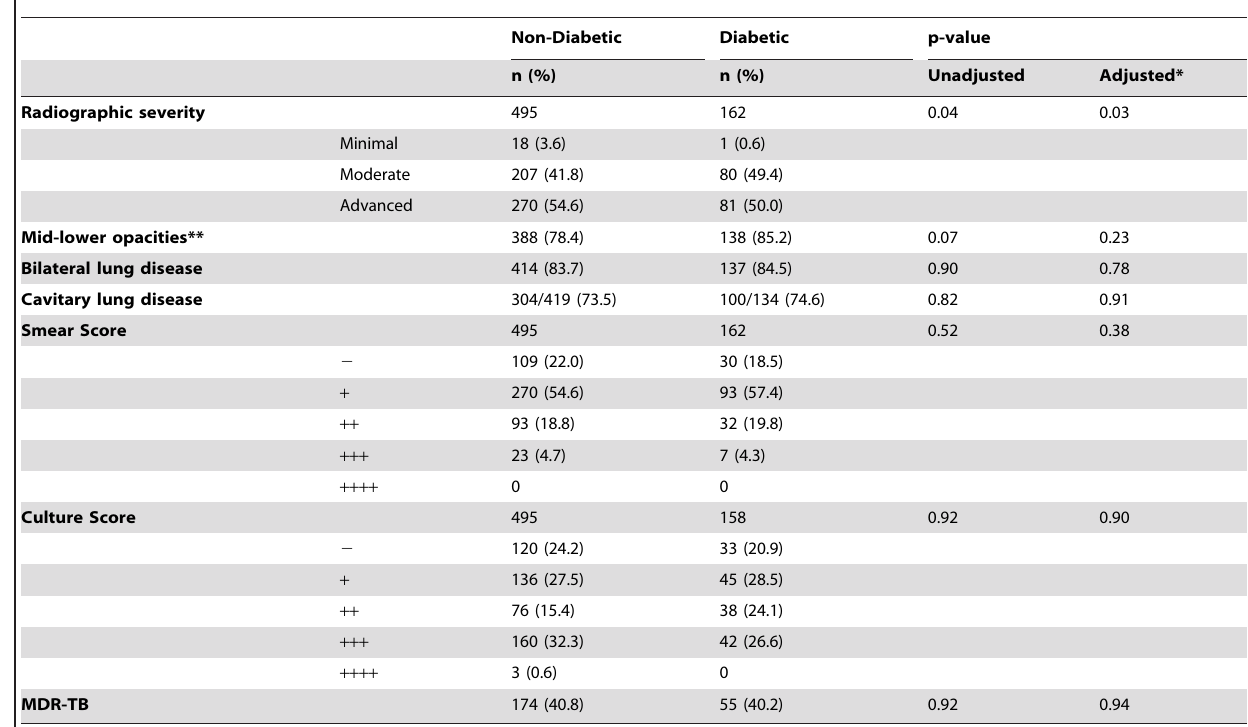
Table 3. Subject characteristics on